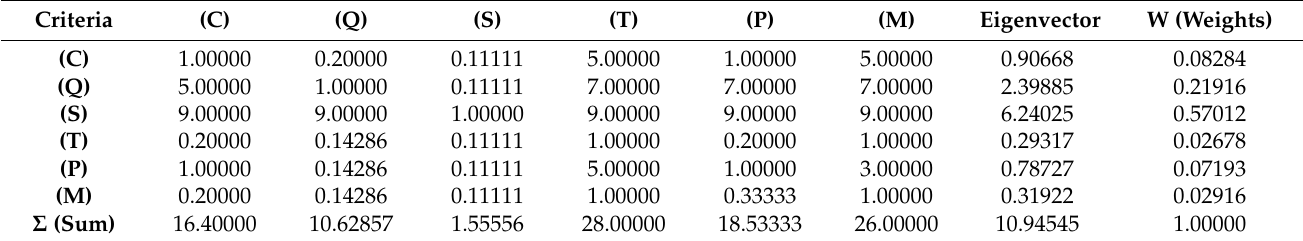
Table 10. Judgment matrix (full packaging engineer C).